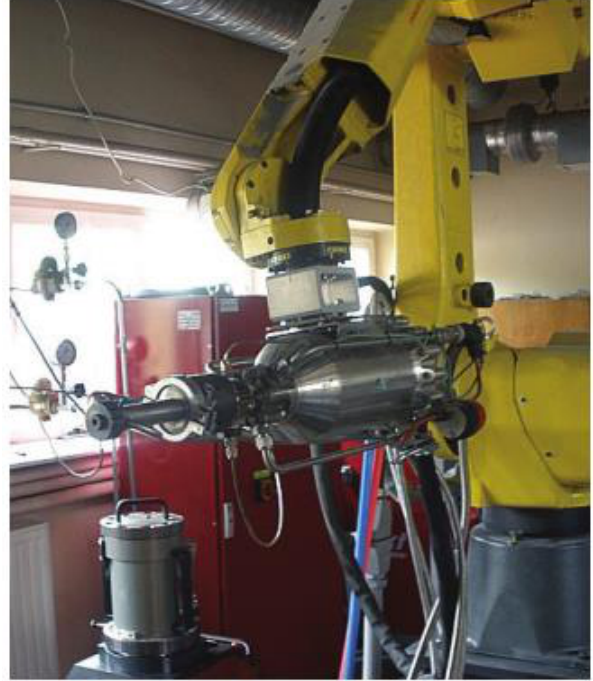
Figure 2. Cold gas spraying station.